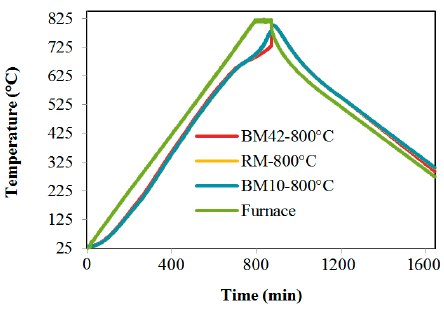
Figure 9. Heating regime of mixtures RM, BM 10 and BM 42 for 800 °C.